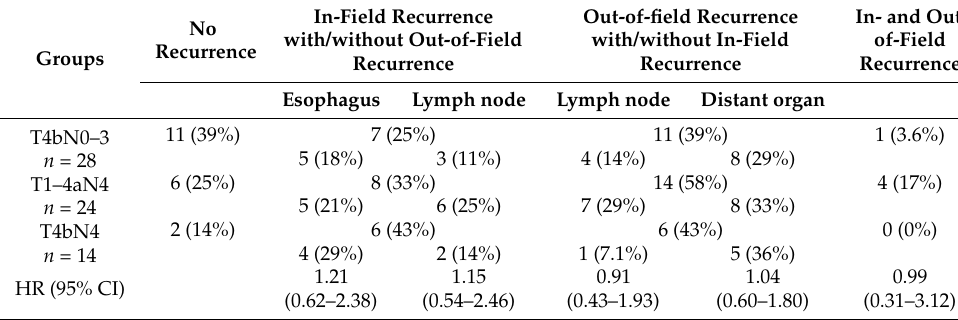
Table 3. Univariable Cox regression analyses of progression patterns.